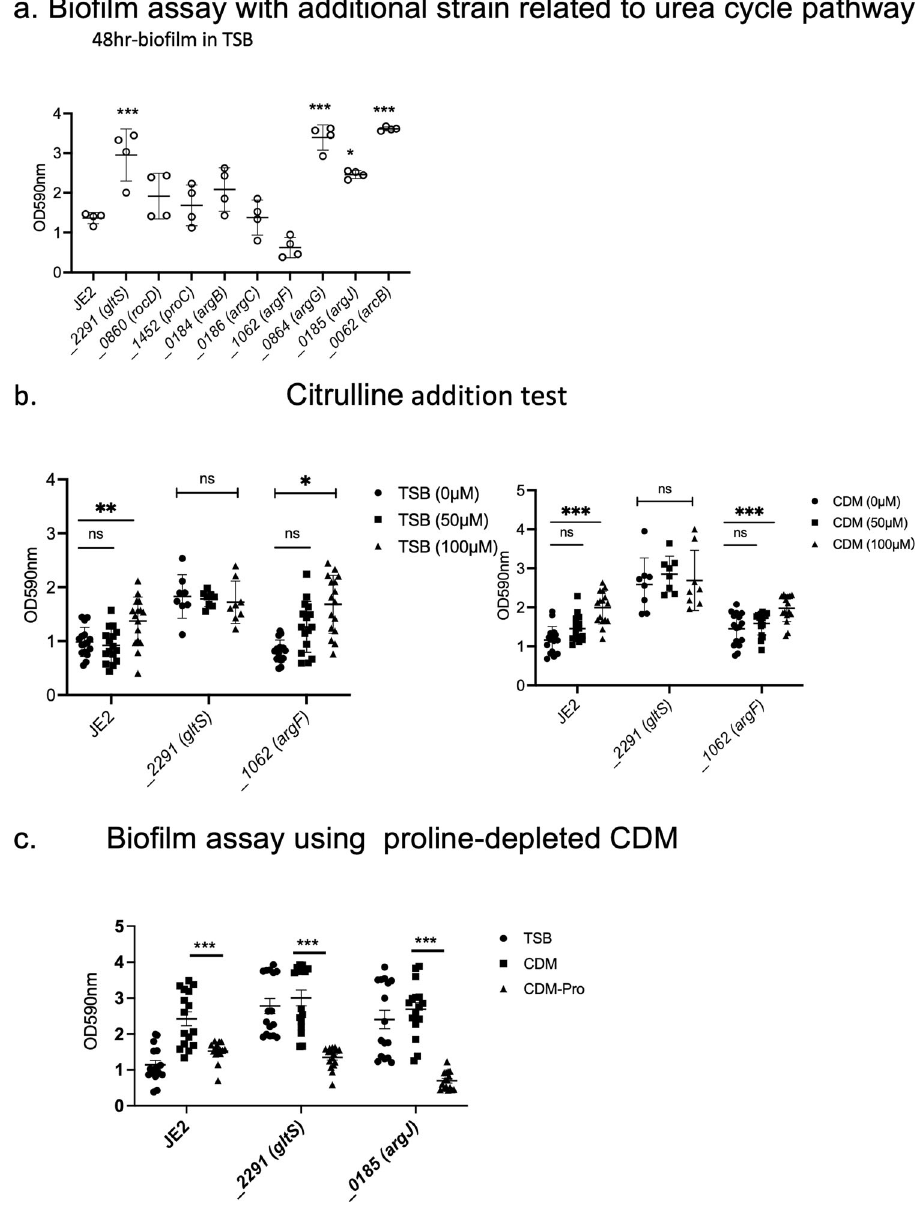
Fig. 8 The role of the urea cycle in bio fi lm formation. a Bio fi lm assay of urea cycle pathway related gene transposon mutants. Bio fi lm quanti fi cation in 1% glucose TSB medium at 48 h. Data are shown as mean ± SD of 8 replicates. One-way ANOVA with post hoc Bonferroni ‘ s multiple comparisons test vs USA300 JE2. *** p < 0.001, * p < 0.05. b 48-h bio fi lm assay using the medium in the presence of additional citrulline (50 µ M, 100 µ M). Data are shown as mean ± SD of 8 replicates. One-way ANOVA with Bonferroni post hoc analysis. * P < 0.05, ** P < 0.01, *** P < 0.001. c Bio fi lm assay using